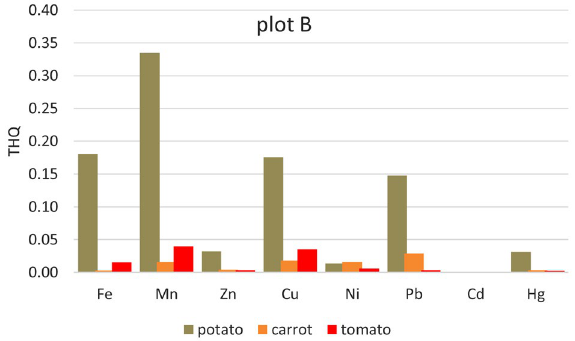
Figure 3. Target hazard quotient (THQ) of heavy metals in potatoes, carrots, and tomatoes grown in plot B.